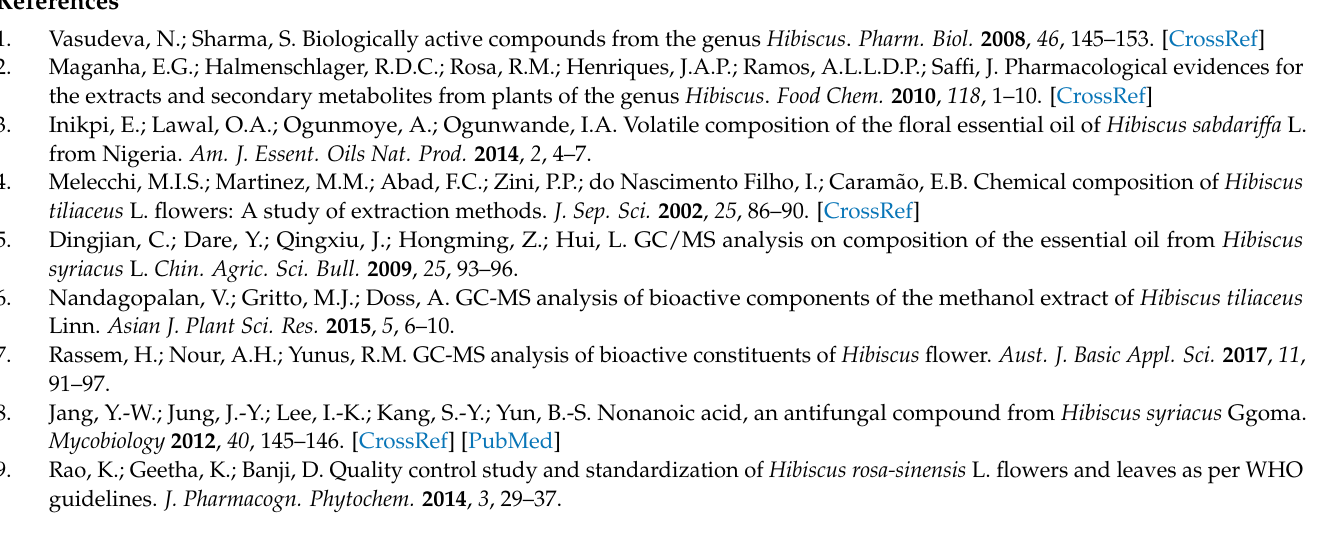
DSC and TG curves of Hibiscus syriacus leaves. Figure S3: GC–MS chromatogram of Hibiscus syriacus flower hydromethanolic extract. Figure S4: GC–MS chromatogram of Hibiscus syriacus leaf hydromethanolic extract. Figure S5: Growth inhibition of D. seriata for the conjugate complexes under